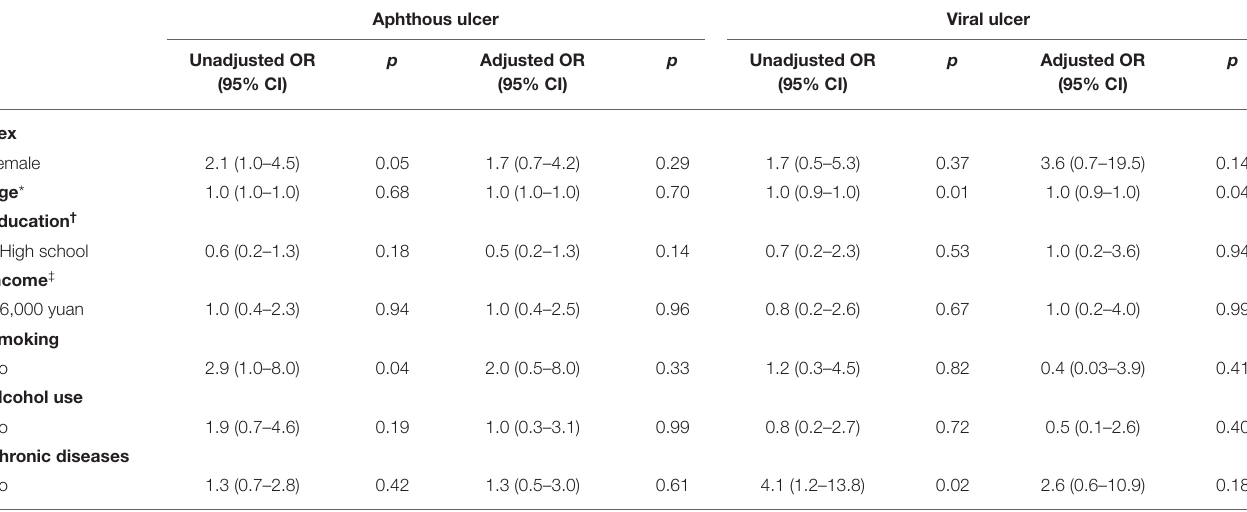
TABLE 5 | Characteristics associated with aphthous ulcer or viral